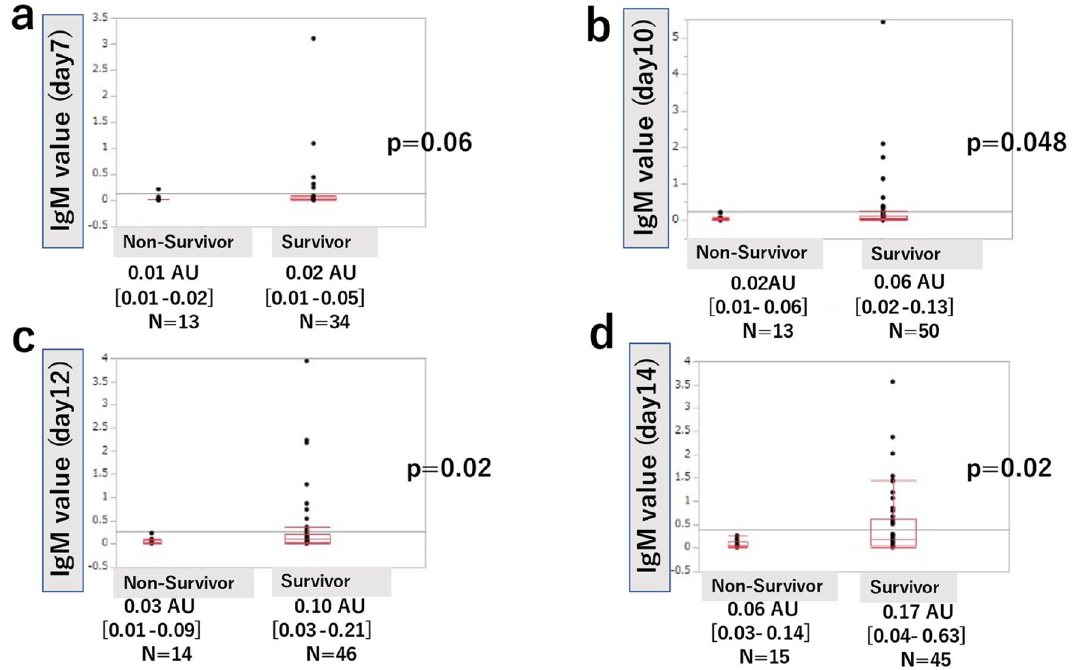
Figure 2. Comparison of daily IgM values between survivors and non-survivors. Antibody titers of IgM on day 7 after onset were not significantly different between the survivor and non-survivor groups ( a ). Antibody titers of IgM on day 10, 12, and 14 after onset were significantly higher in the survivor group ( b , c , d ). Values represent median and interquartile range. N total number of patients. P < 0.05 indicates a significant difference. IgM immunoglobulin